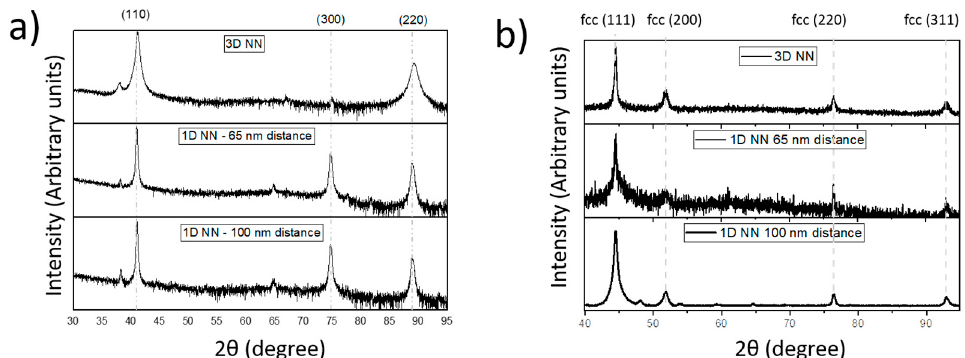
Figure A1. X-ray diffraction measurements of the different 1D and 3D nanowire structures made of ( a ) Bi 2 Te 3 and ( b ) Ni. The different peaks have been identified with the references JCPDS-ICDD-00- 0150863 in the case of Bismuth Telluride and JCPDS-ICDD-00-0040850 for Nickel.